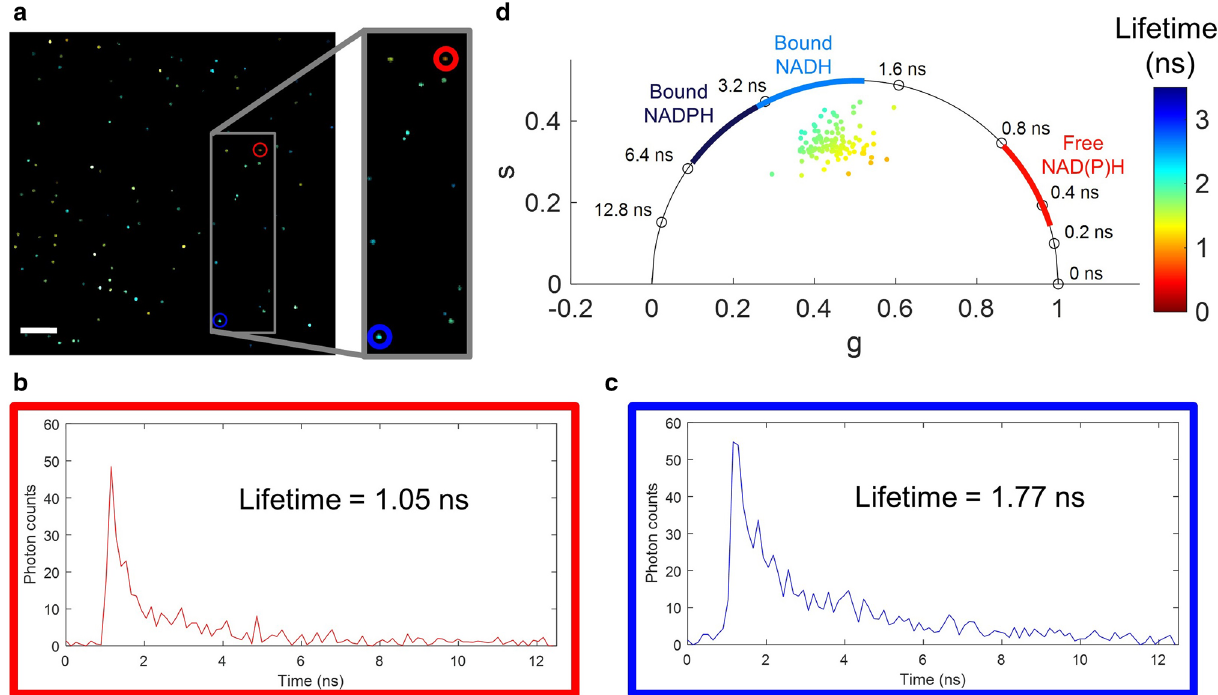
Figure 1. Heterogeneity of fluorescence lifetimes in extracellular vesicles (EVs). ( a ) Fluorescence lifetime- weighted intensity image of EVs derived from MDA-MB-231 cells. The brightness of a pixel corresponds to intensity and the color corresponds to fluorescence lifetime in nanoseconds, using the same fluorescence lifetime scale as in panel ( d ). ( b ) Example fluorescence decay curve of a shorter fluorescence lifetime corresponding to the EV in the red circle in panel ( a ). ( c ) Example fluorescence decay curve of a longer fluorescence lifetime corresponding to the EV in the blue circle in panel ( a ). ( d ) Phasor plot of the frequency components of the exponential decays. Each point on the plot represents a single EV from the image in ( a ). The color of the point represents the fluorescence lifetime of the EV in nanoseconds. Approximate fluorescence lifetime values of protein-bound and free NAD(P)H are labeled based on previous studies 25,33 . Scale bar represents 20